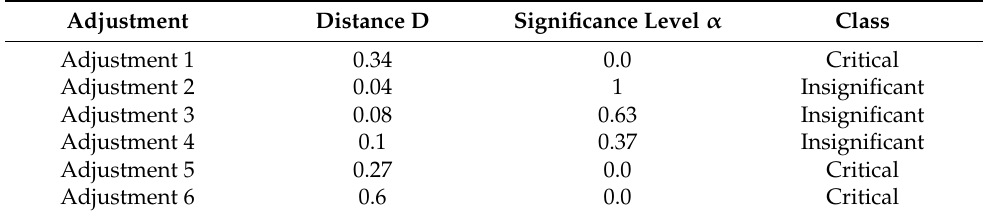
Table 4. Results of regional sensitivity analysis.